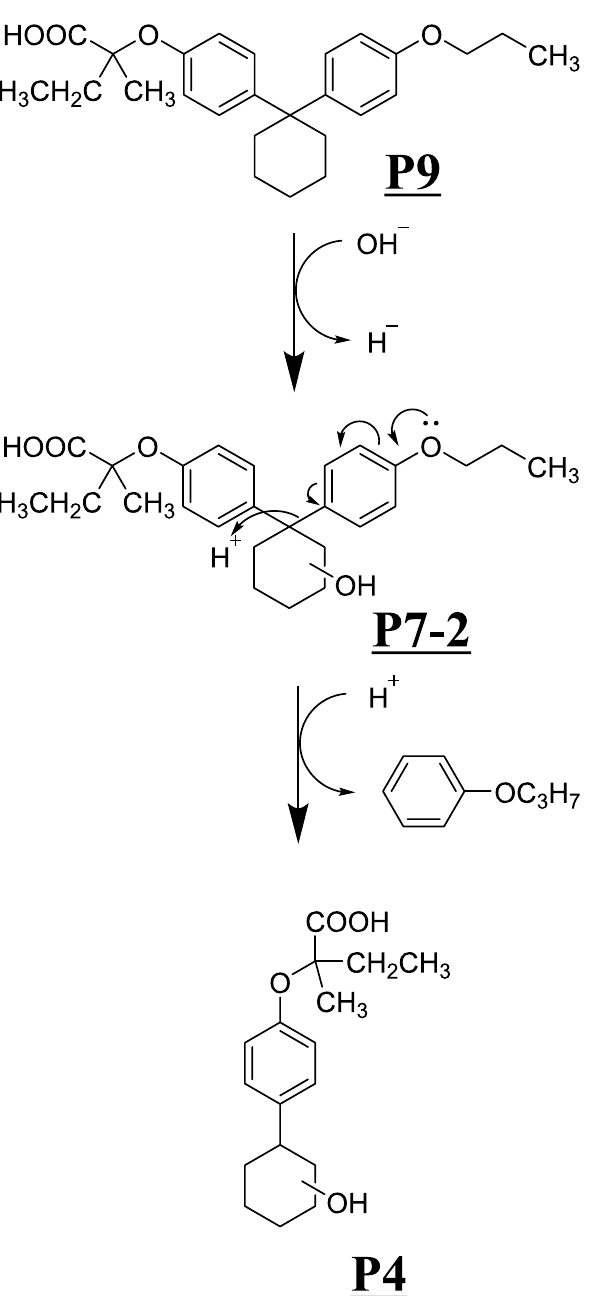
Fig. 6 Proposed photodegradation pathways for P7-2 and P4 from